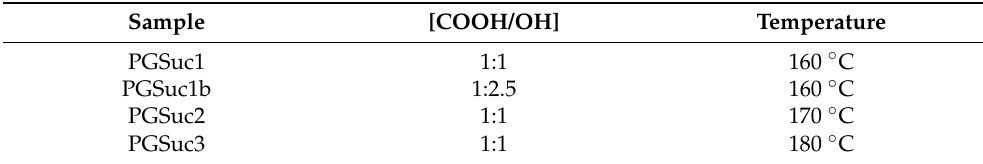
Table 1. Prepared samples based on different